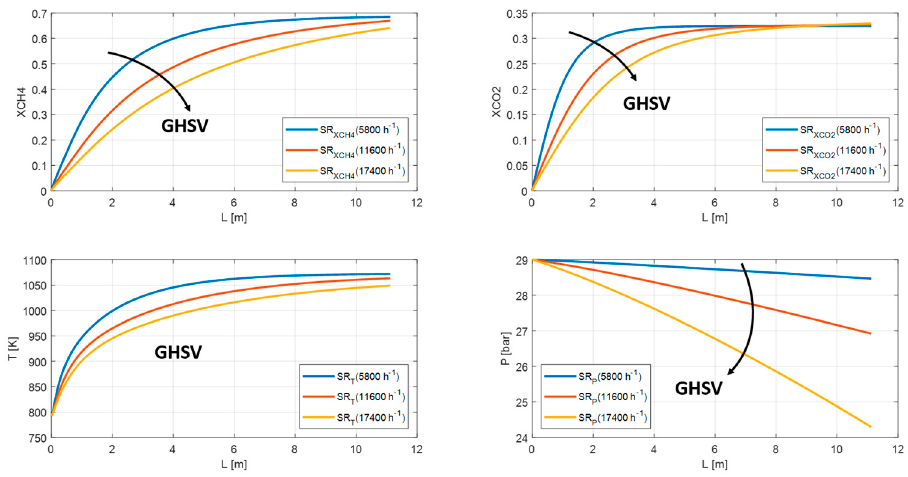
Figure 12. Methane conversion, carbon dioxide yield, temperature, and pressure profile in SR for GHSV = 5800, 11,600, 17,400 h − 1 .